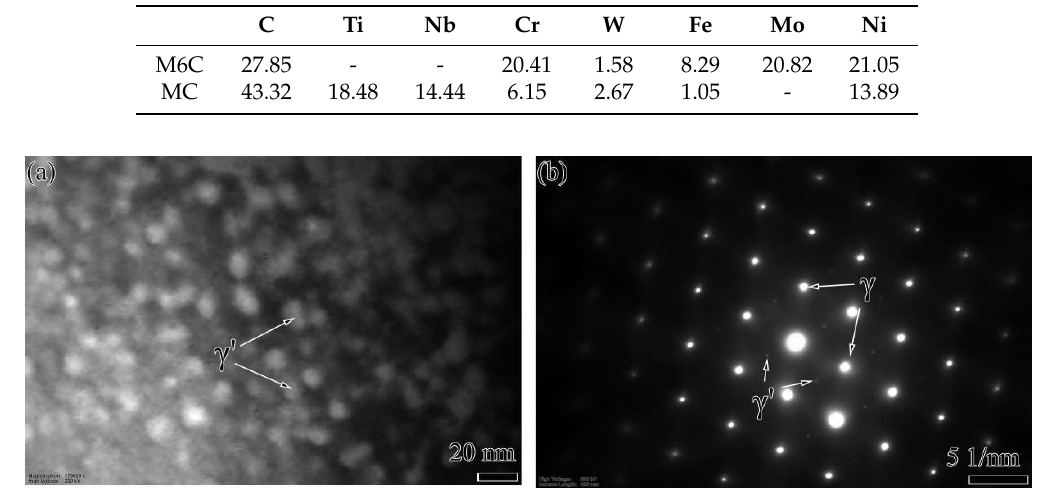
Figure 4. TEM analysis of γ’ in as-received K4750 base metal: ( a ) bright filed image of γ’; and ( b ) SADP (selected area electron diffraction pattern) image of γ’ and γ.